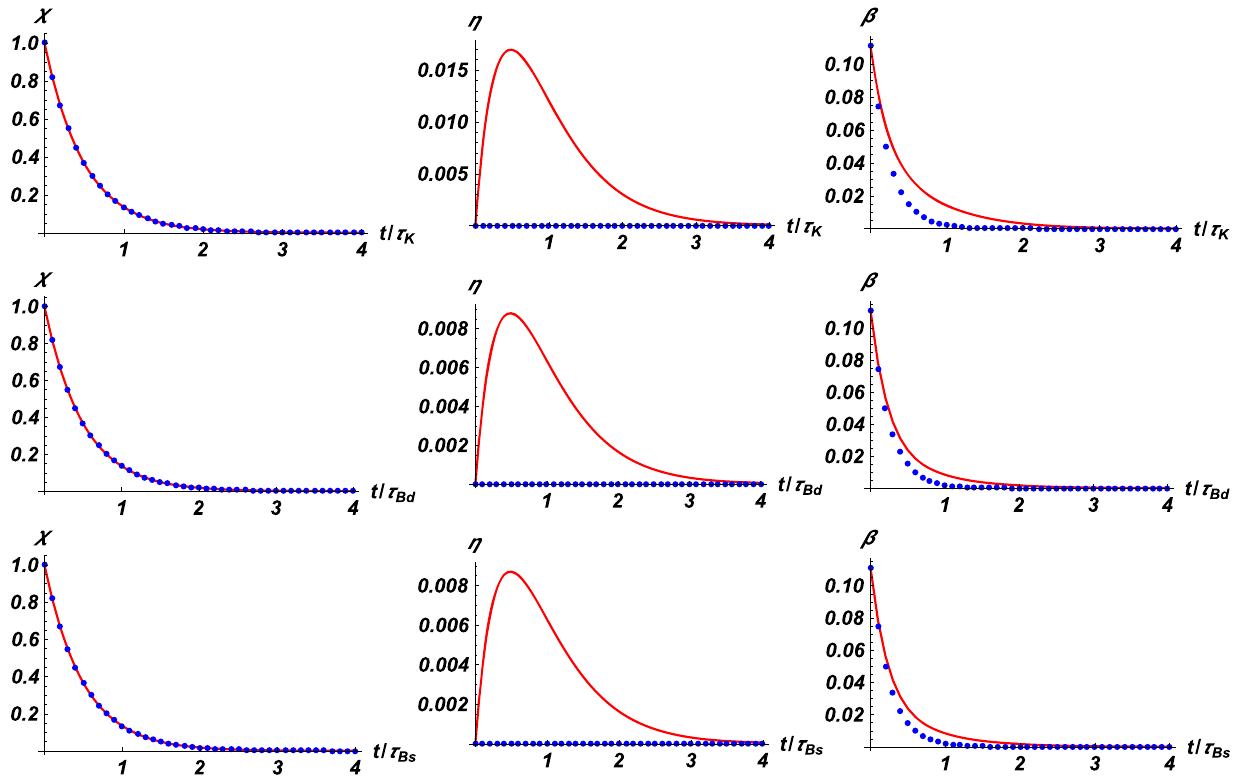
Fig. 1 Meson system. Coherence parameter χ(ρ) (left), mixedness Thesolid(red)anddotted(blue)correspondtothecasewithandwithout parameter η(ρ) (middle) and complementarity parameter β(ρ) (right) decoherence, respectively. In all the three cases, the average mixedness as function of the dimensionless quantity t /τ K ( B . Top, middle and increases for about one lifetime of the particles d , B s ) bottom panels pertain to the case of K, B d and B s mesons, respectively.